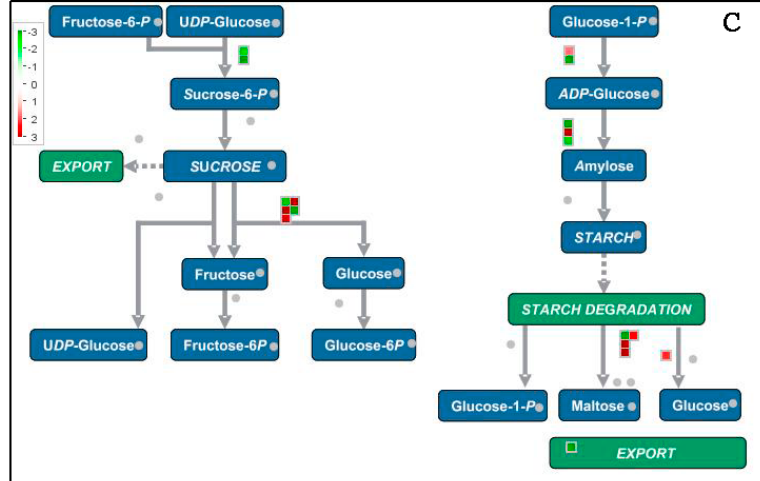
Figure 9. Schematic diagram of starch and sucrose metabolism using the MapMan visualization platform. The gene expression ratios of P2 ( A ), P3 ( B ), and P4 ( C ) compared with P1 were used in MapMan analysis. The red squares and green squares indicate up- or down-regulated genes involved in starch and sucrose metabolism, respectively.